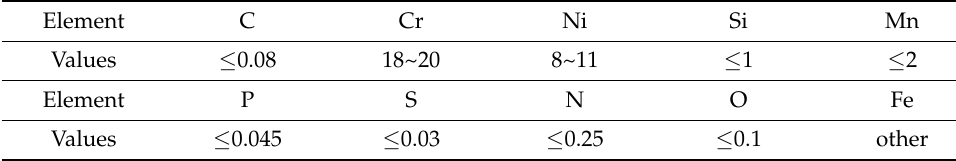
Table 1. Chemical component of material table, wt%.